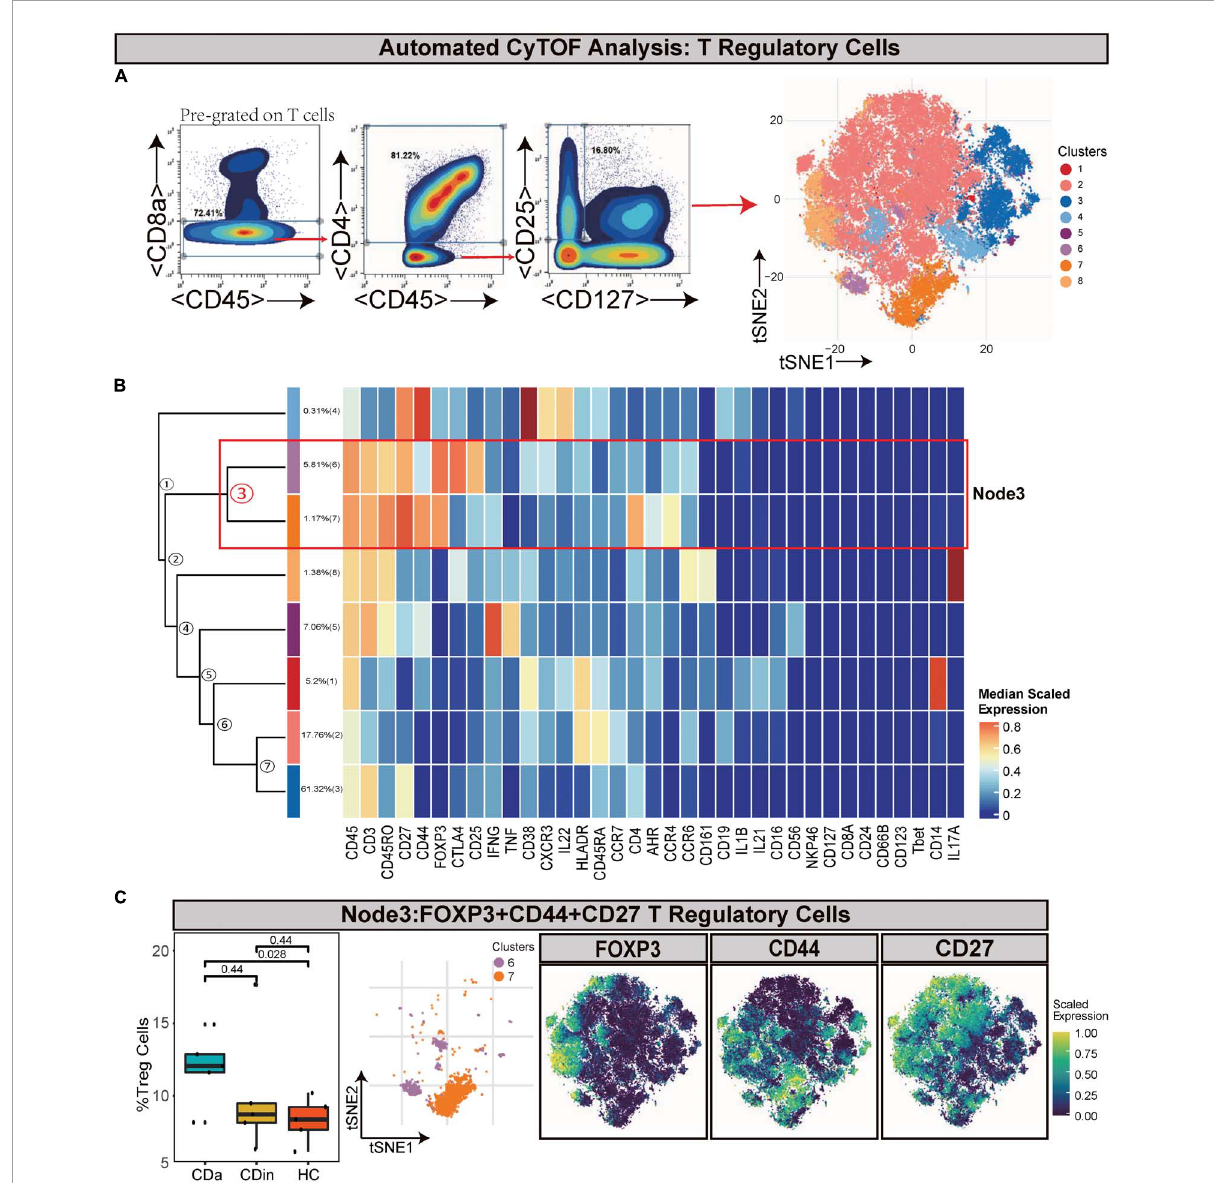
FIGURE3 CyTOF analysis showed differences in T regulatory cells among CDa, CDin, and HC. (A) Gating strategy (left) and t-SNE projection (right) of T regulatory cells (Tregs) derived from CyTOF data. (B) Cluster dendrogram and heatmap of Tregs. (C) The percentage of Node3 in Tregs among three groups (left) and the t-SNE plot of Node3 with gene expression feature plot for FOXP3/CD44/CD27